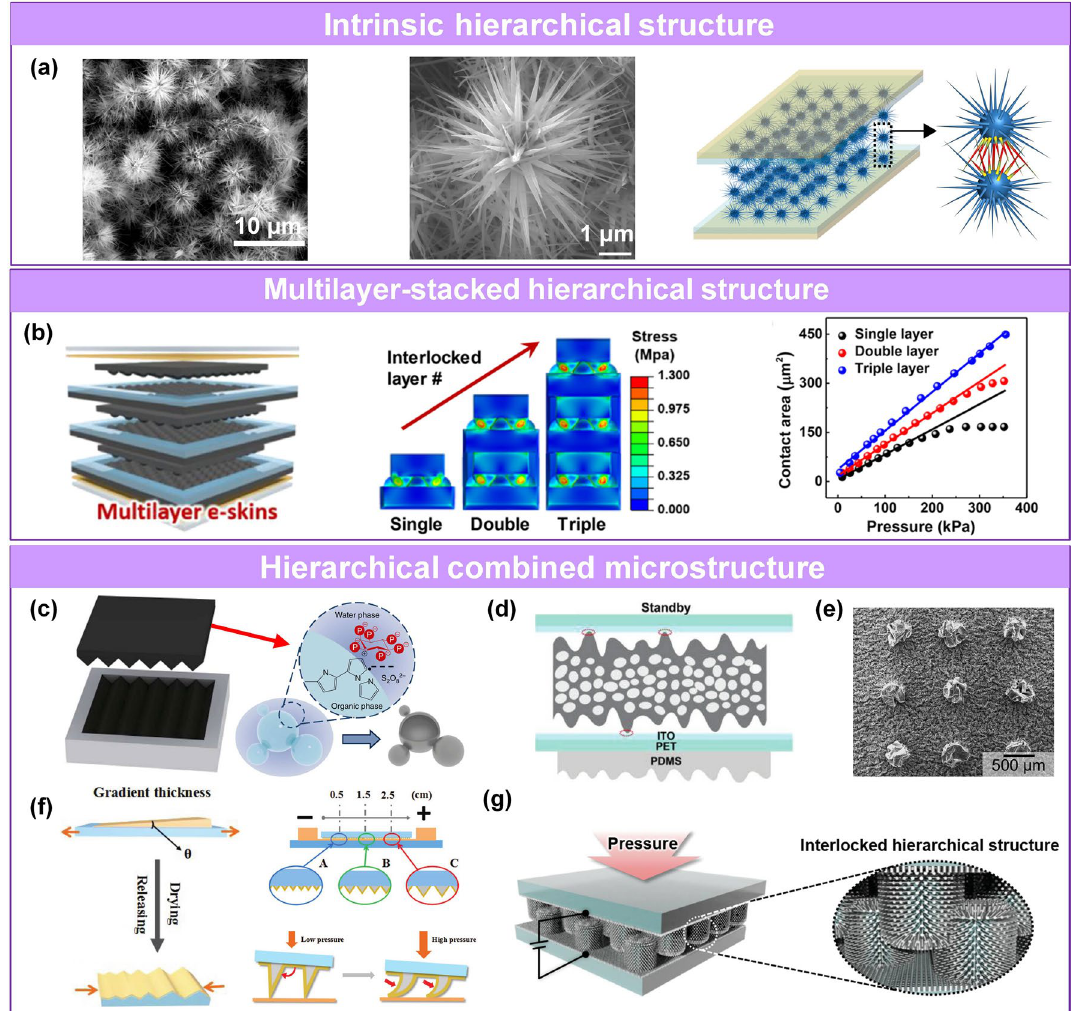
Fig. 6 Sensing materials with multiscale hierarchical microstructures. a Intrinsic hierarchical structure with tapering spine [74]. Copyright (2018) The Authors. b Schematic diagram, pressure distribution simulation and sensing performance comparison of multilayer-stacked structure [107]. Copyright (2018) American Chemical Society. c Combined hierarchical structure of the hollow material is molded into a slightly rough surface [82]. Copyright (2014) Springer Nature. d Porous with microrough structure [108]. Copyright (2019) Wiley–VCH. e Wrinkles